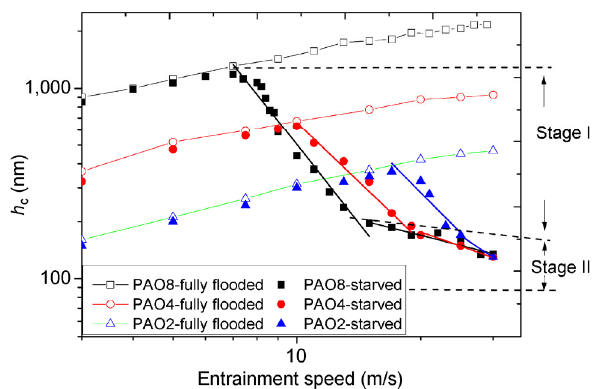
Fig. 10 Film formations of fully flooded and starved conditions at speed up to 30 m/s, measured by Liang et al. [82]. Copyright 2015, Elsevier Ltd.